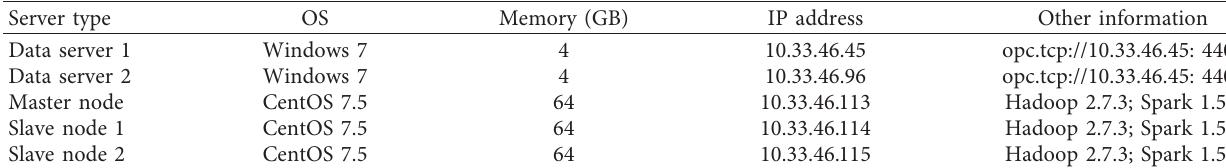
Figure 5: Parallel distributed GRU prediction model based on Table 1: Overall deployment of the cloud platform.